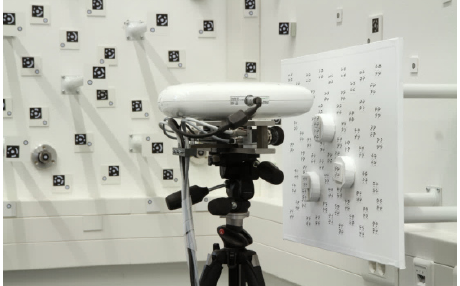
Figure 4. Calibration of the camera system with a reference object on a wall